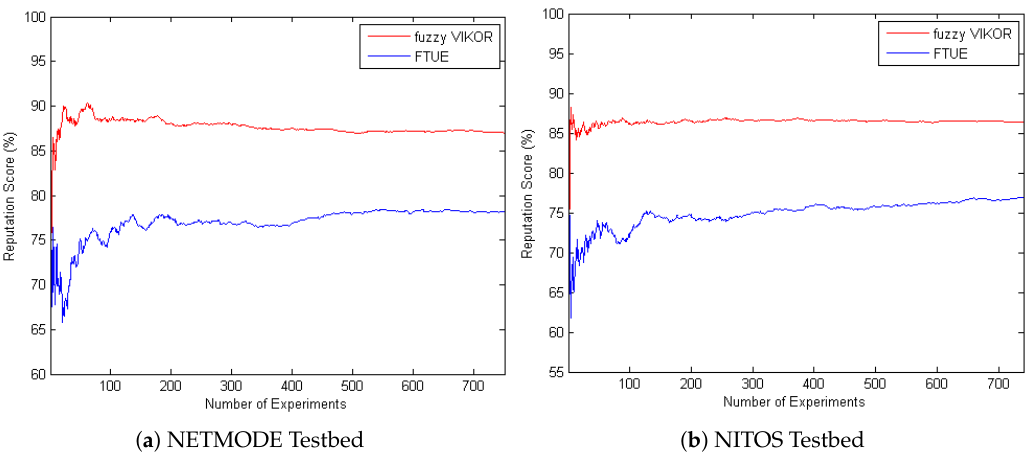
Figure 5. Comparison of fuzzy reputation system with the